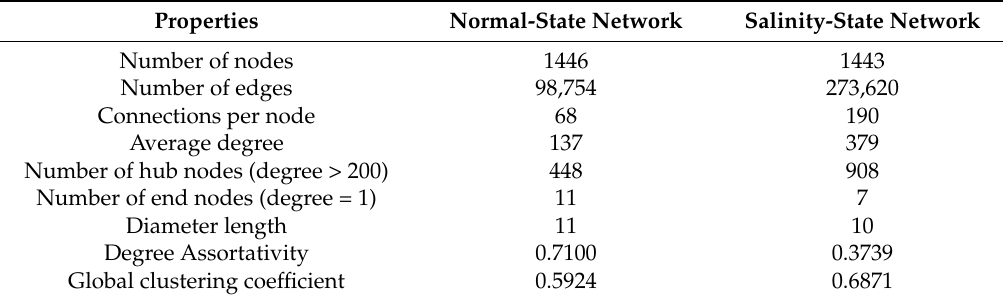
Table 4. Node and network